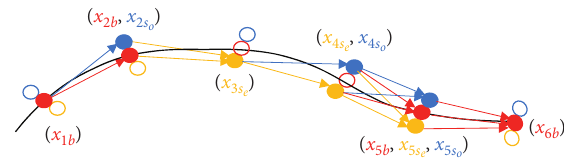
Figure 6: An example of different orientations that can occur between six points for the